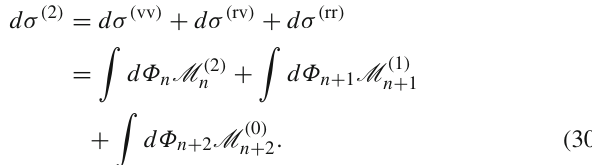
( 2 ) ( 0 ) is 1 /(cid:11) 4 which corresponds to the highest pole of M n double-soft-collinear poles. On the other hand, M ( z ) will only have 1 /(cid:11) 2 poles. The double-soft-collinear M ( 2 ) n poles are now replaced by 1 /(cid:11) 2 log 2 ( z )